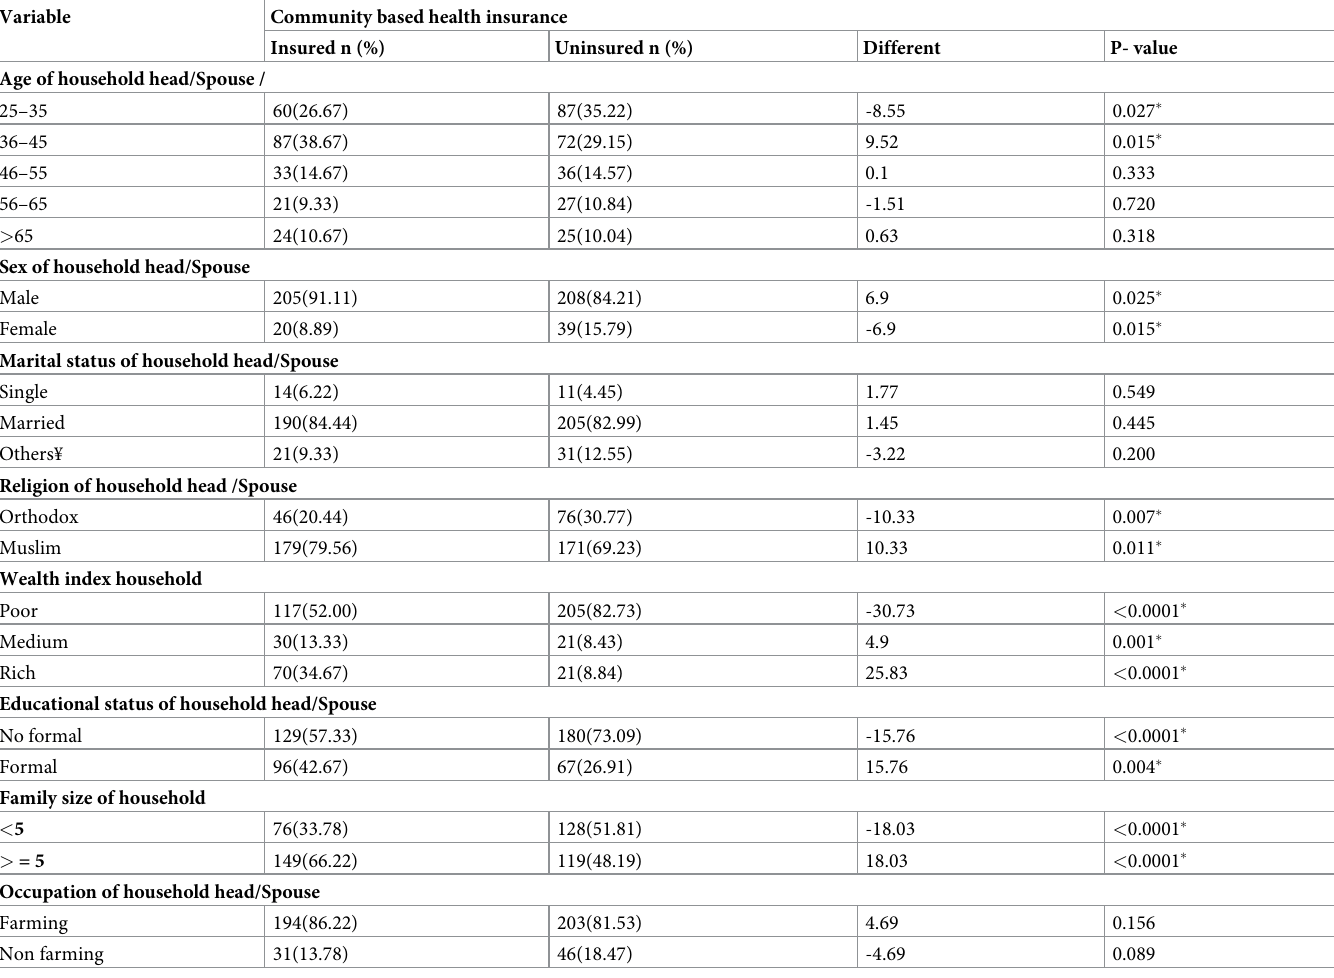
Table 1. Demographic and socio-economic characteristics of insured and uninsured households in Kutaber district, Ethiopia, 2020 (n = 472).